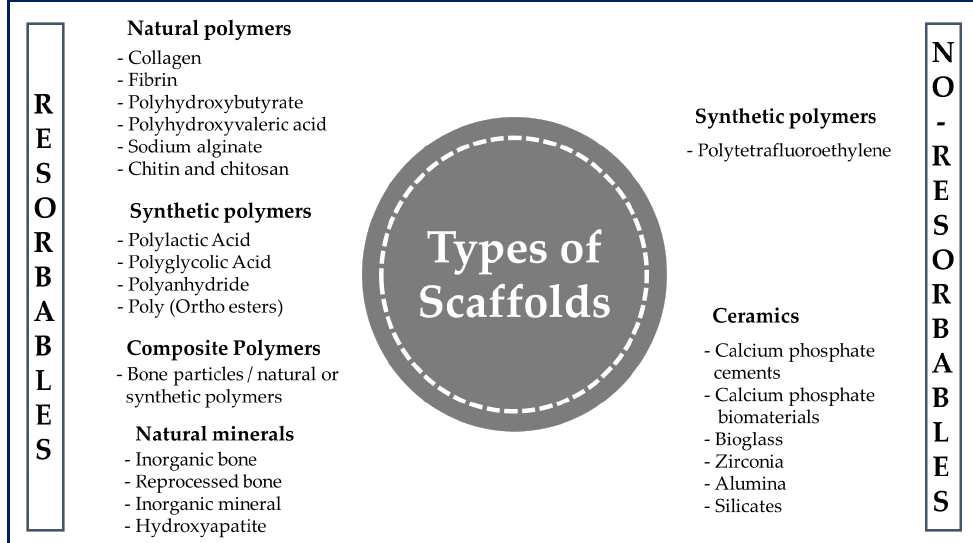
Figure 6. General classification of polymers for medical